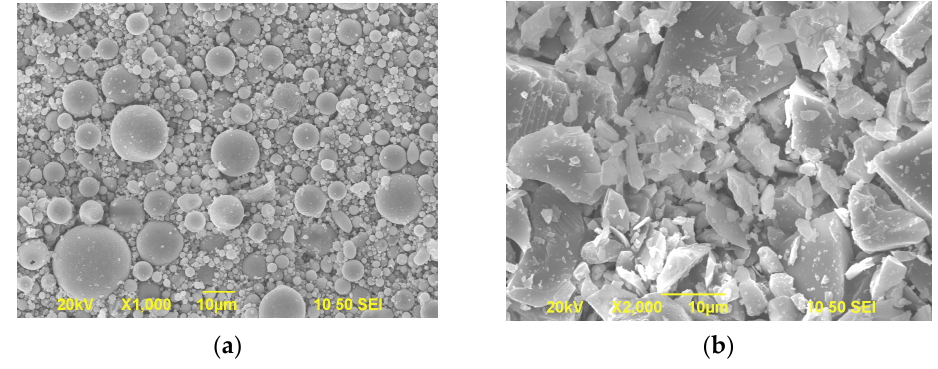
Figure 2. SEM images of GP-2h ( a ) and FA ( b ).